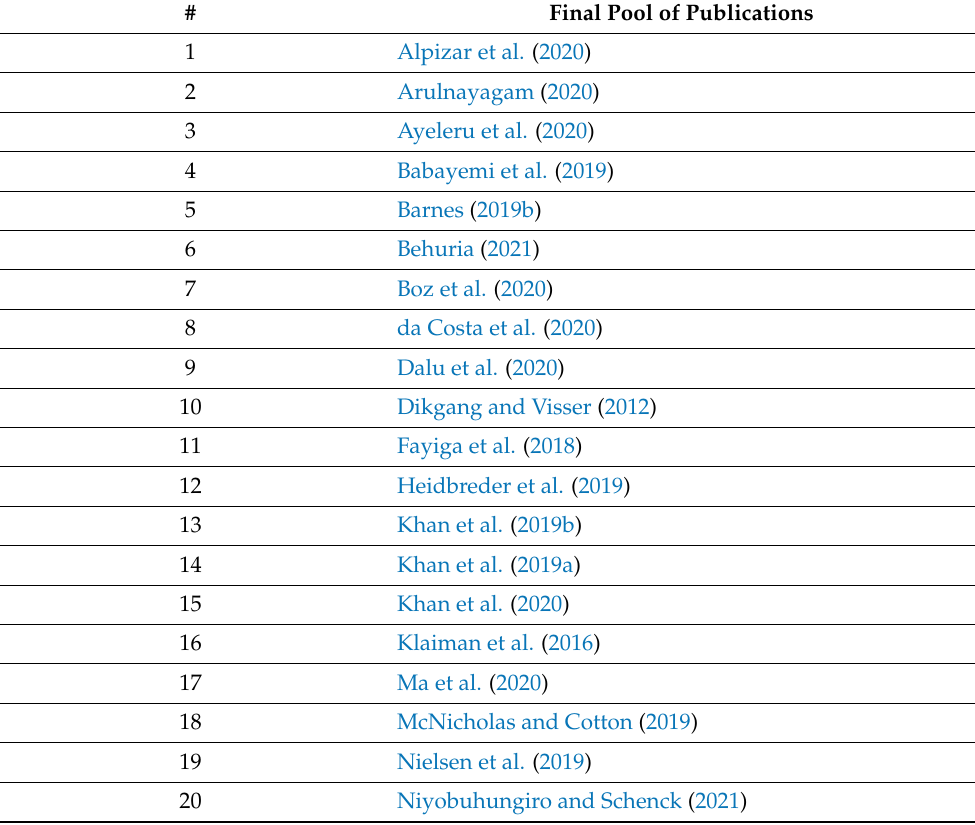
Table 1. Final pool of